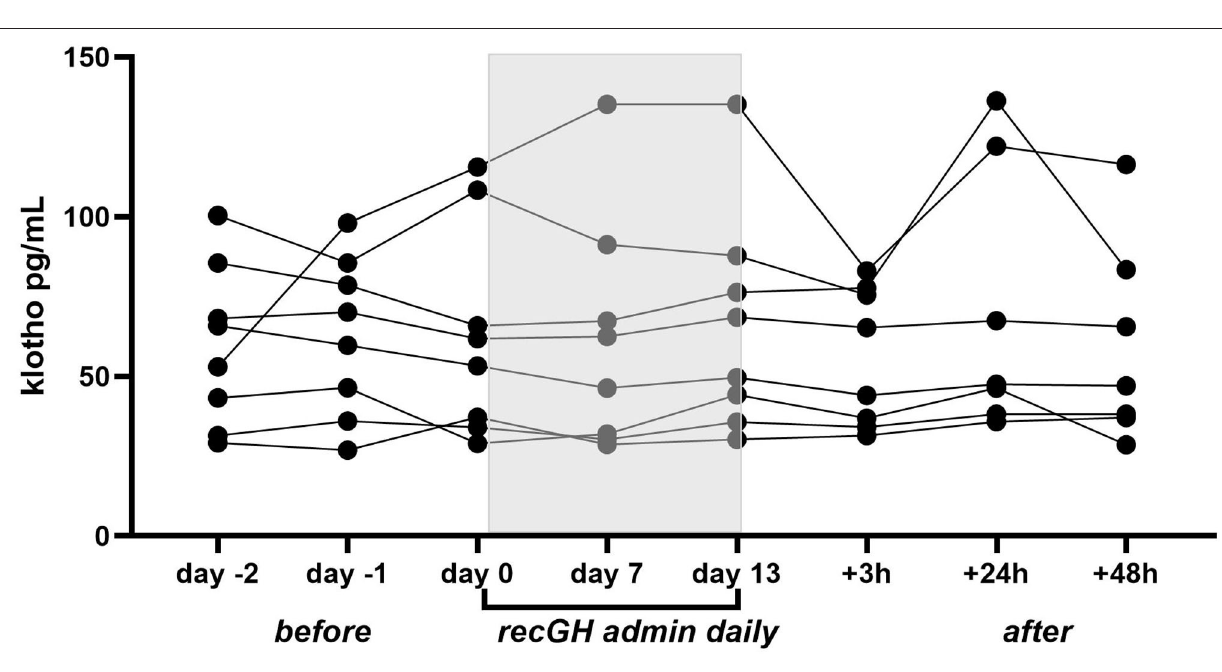
showed a strong negative correlation to IGF-I concentration before GH administration ( r = − 0.86, p = 0.006), Figure 3A . Also, after GH administration, a similar correlation remained ( r = − 0.86, p = 0.006), Figure 3B